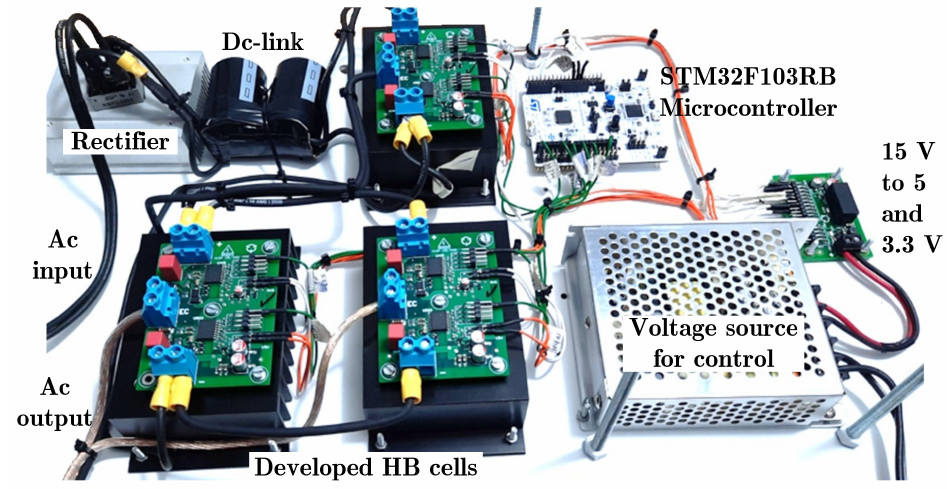
Figure 13. Photograph of the experimental